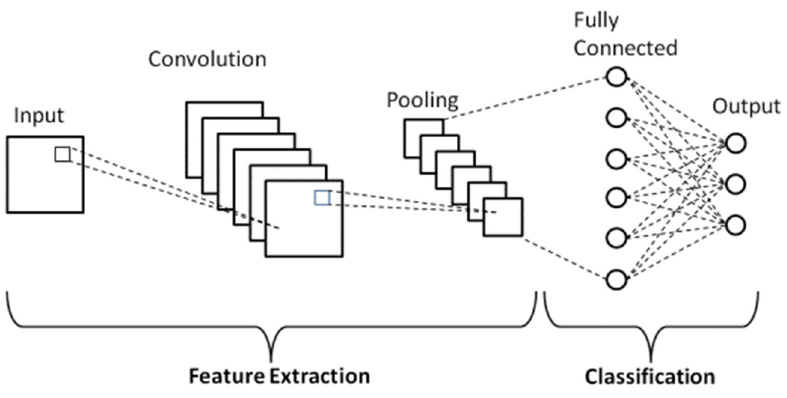
Figure 1. Deep CNN Architecture.